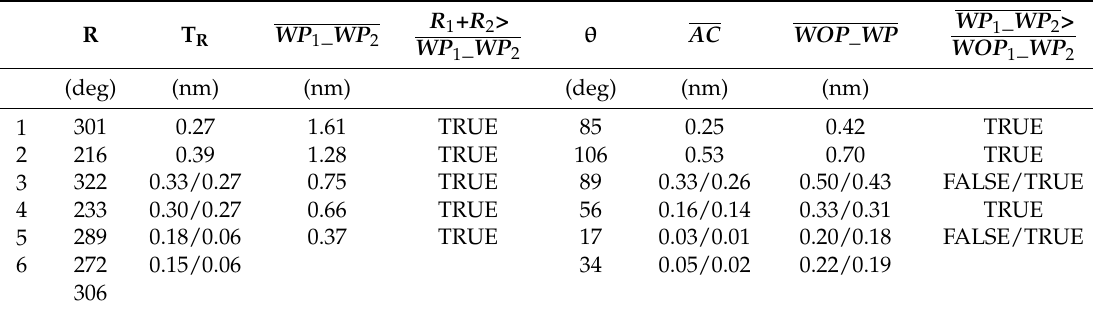
Table 1. First and last set of measures in the area of